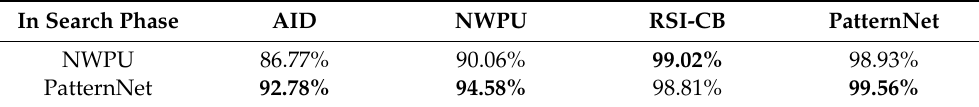
Table 2. The OA of four benchmark datasets is computed by the optimal model which searched the structure using the NWPU/PatternNet datasets as the training data for search phase. In Search Phase AID NWPU RSI-CB PatternNet NWPU 86.77% PatternNet